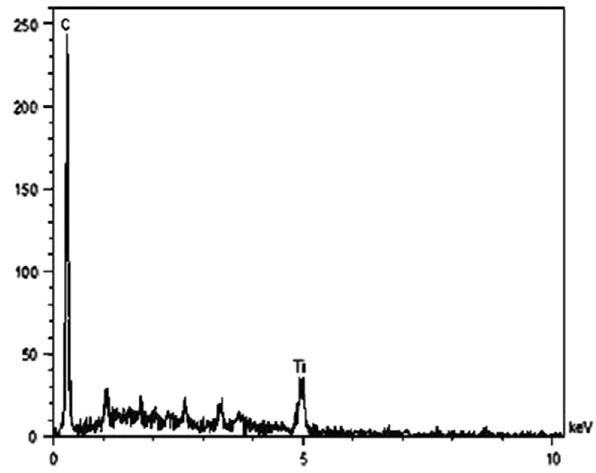
Fig. 2 EDX spectrum of the used cigarette filter ash